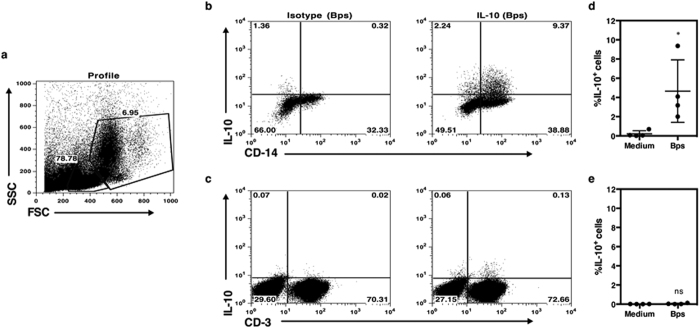
CD3− CD14+ monocytes are the main IL-10 producers in response to B. pseudomallei.PBMCs from healthy seropositive individuals were incubated with killed B. pseudomallei for 20 hours and, intracellular IL-10 versus cell surface expression of either CD3 or CD14 detected by flow cytometry. The profile (a) of one representative donor was gated on monocytes (b) and lymphocytes (c). d and e shows the frequency of IL-10 producing CD3−CD14+ monocytes (d) or CD3+ lymphocytes (e) from multiple individuals (n = 4). The data in (d) are presented with the mean and the standard deviation. Statistical significance of killed B. pseudomallei versus medium alone was determined using paired T test; ns, non significant, *p < 0.05, **p < 0.01 and ***p < 0.001.